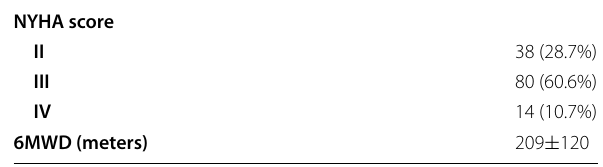
Table 2 Patients’ clinical evaluation ( n